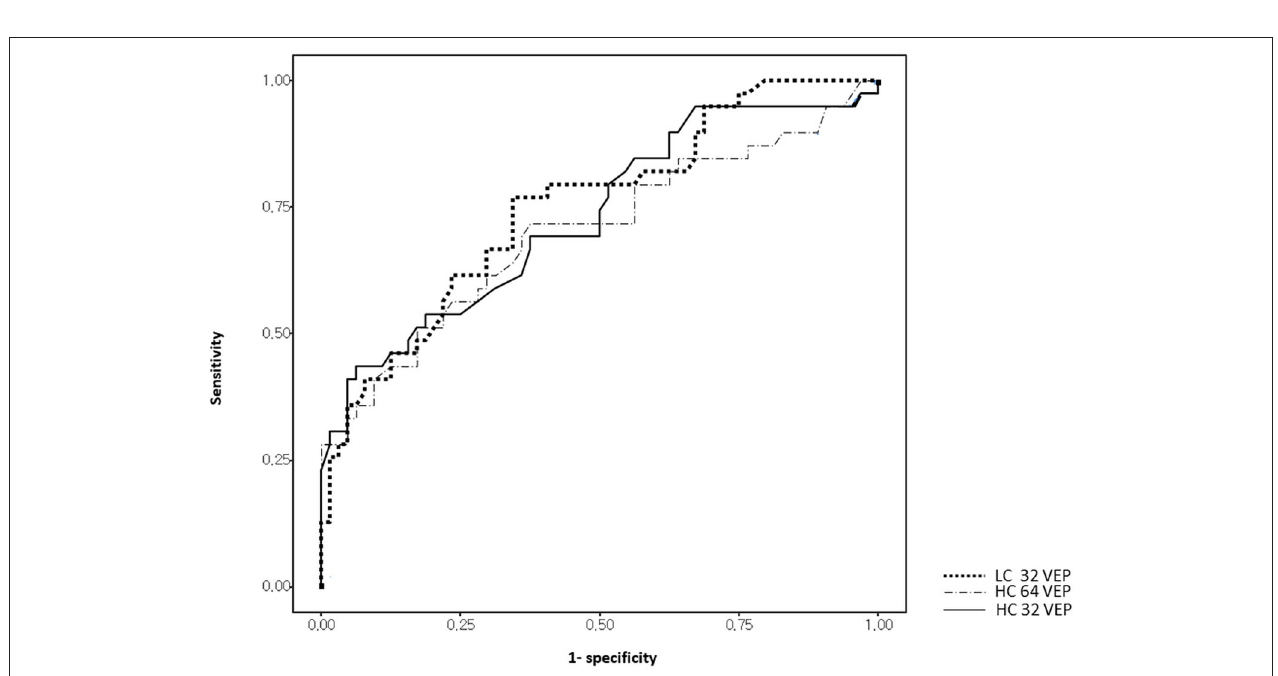
FIGURE 3 | Receiver operating characteristic (ROC) curves of visual measures for discrimination between first-episode optic neuritis (ON) and controls.